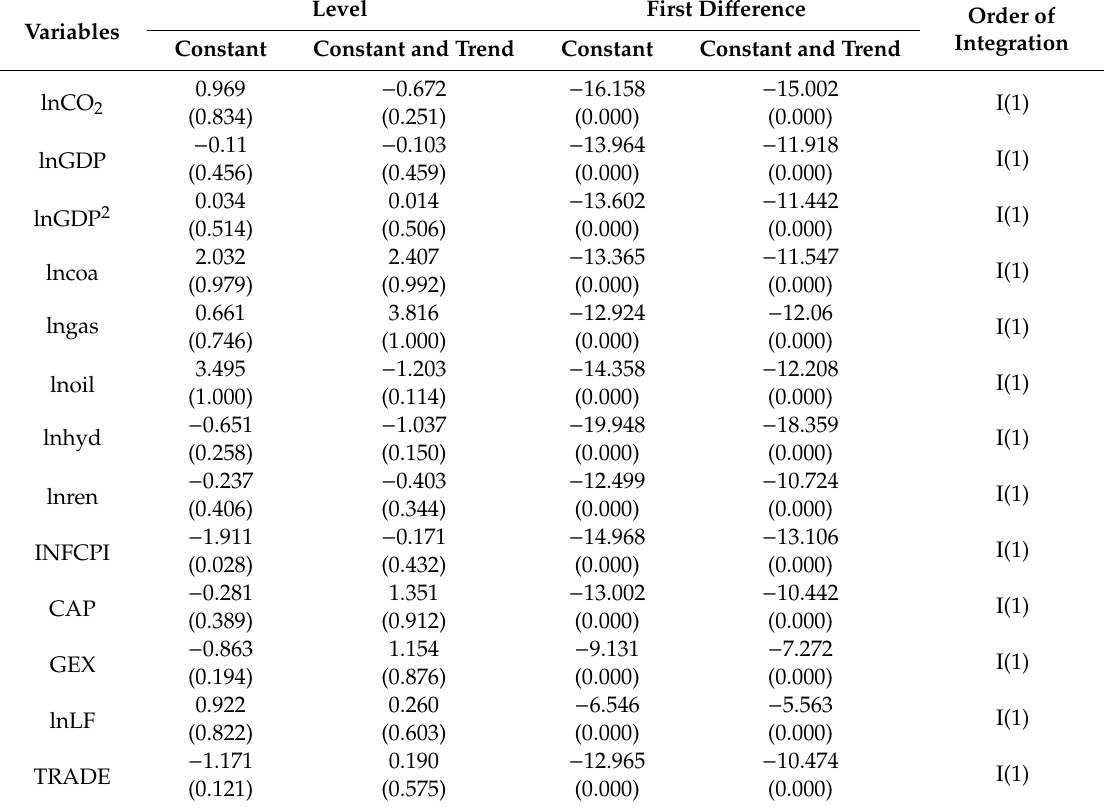
Table 4. Unit root test using Pesaran test.